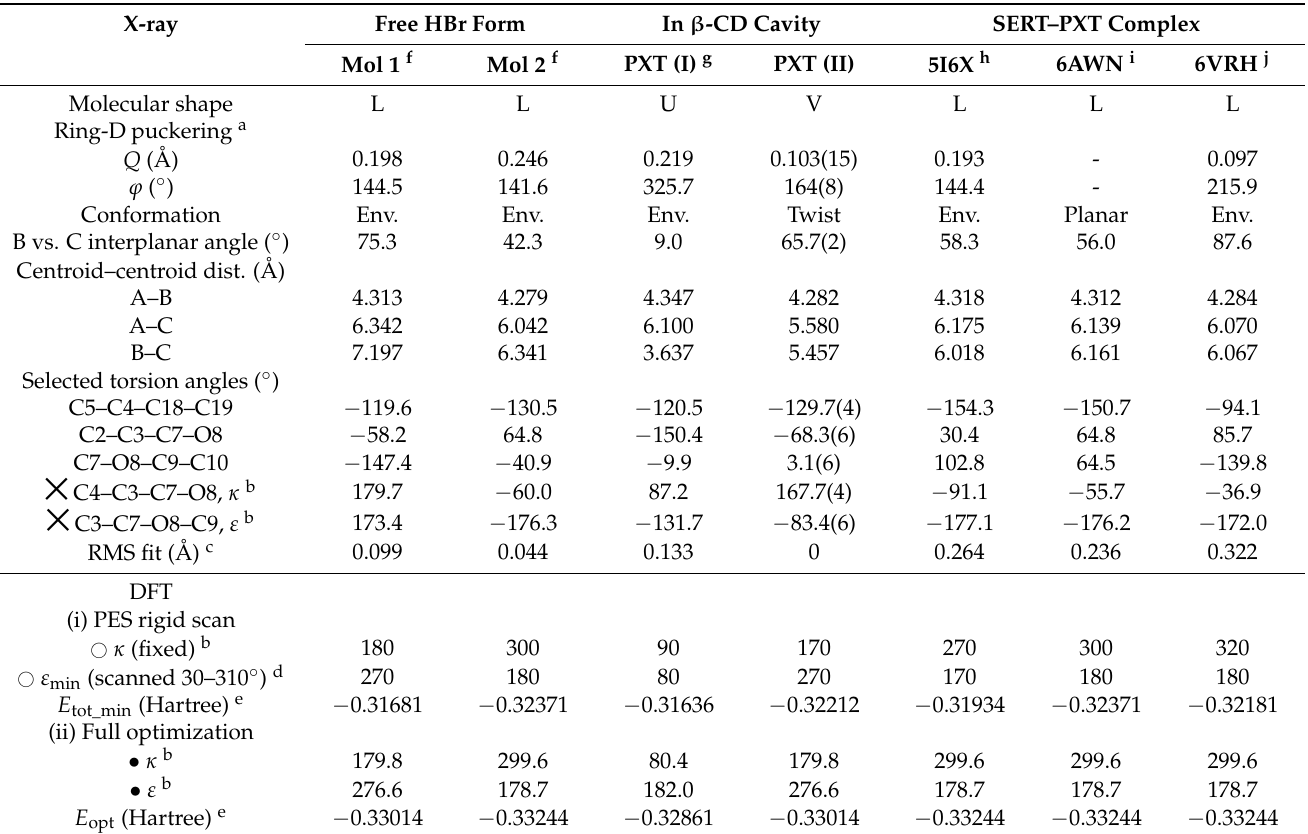
Table 3. Conformational parameters of PXT in uncomplexed form, in β -CD cavity (I, II) and in complex with SERT, derived from X-ray analysis and DFT